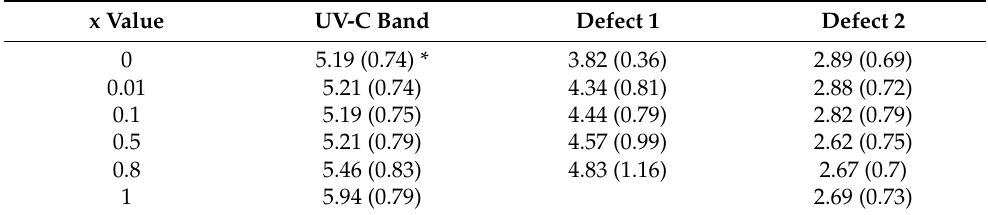
Table 3. Parameters of deconvolution of emission spectra into main Gauss components—peak position and FWHM (in brackets), eV.